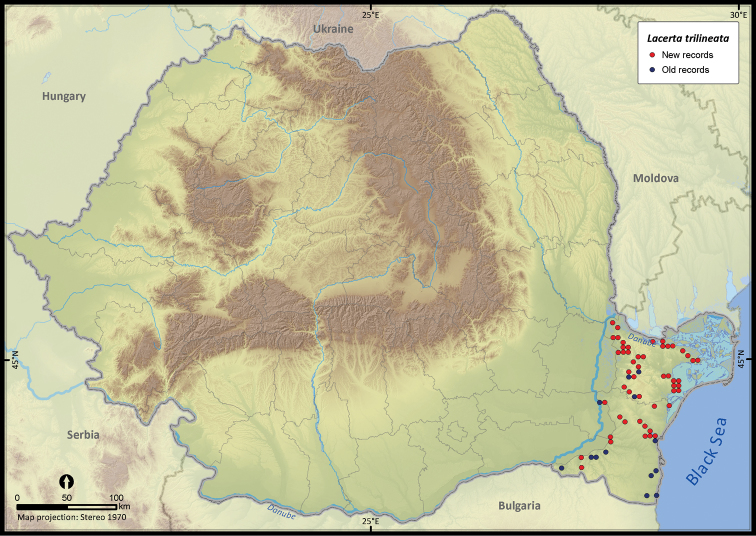
Lacerta trilineata.